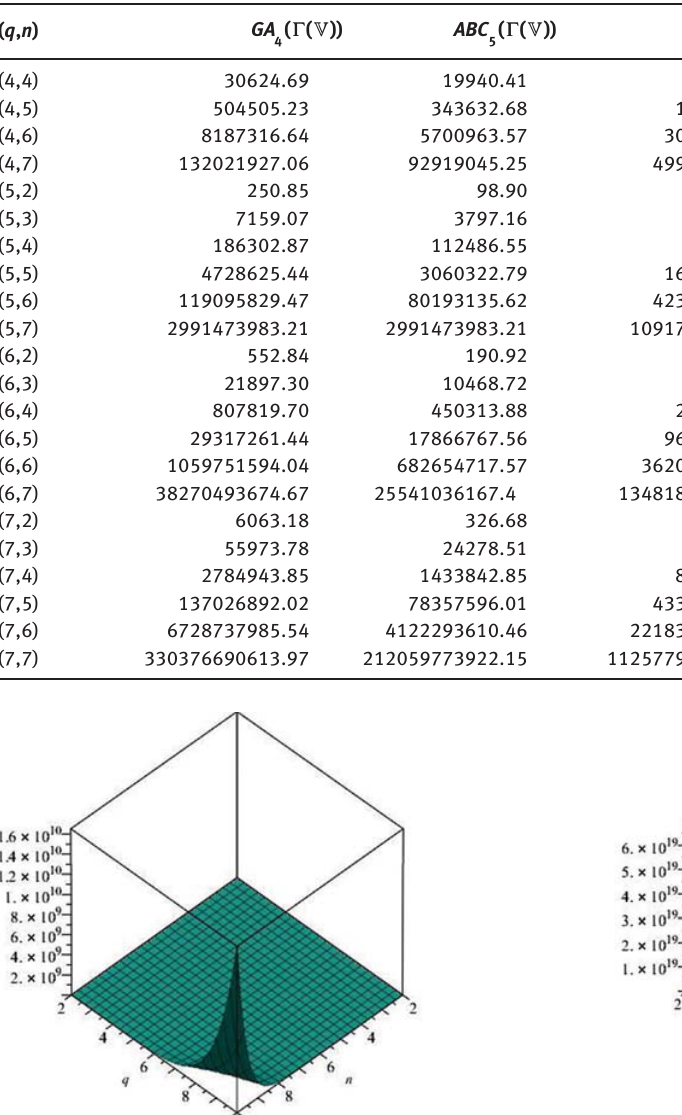
Figure 1: Plot of the total eccentricity.